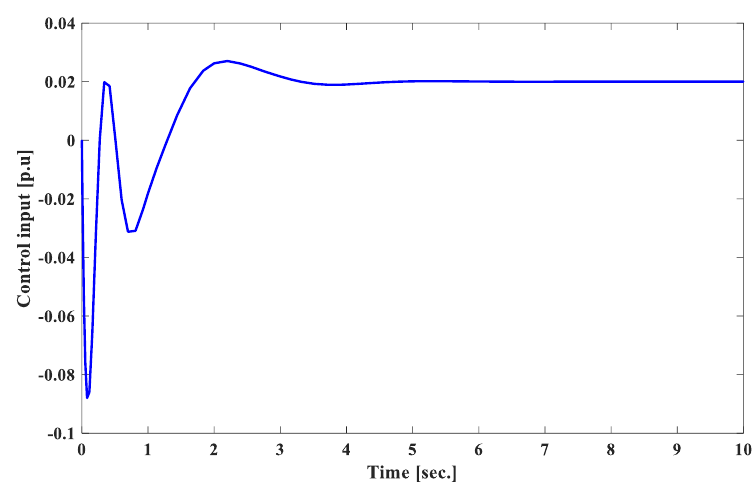
Figure 22. Control input [p.u.] of the second control area under matched disturbances.